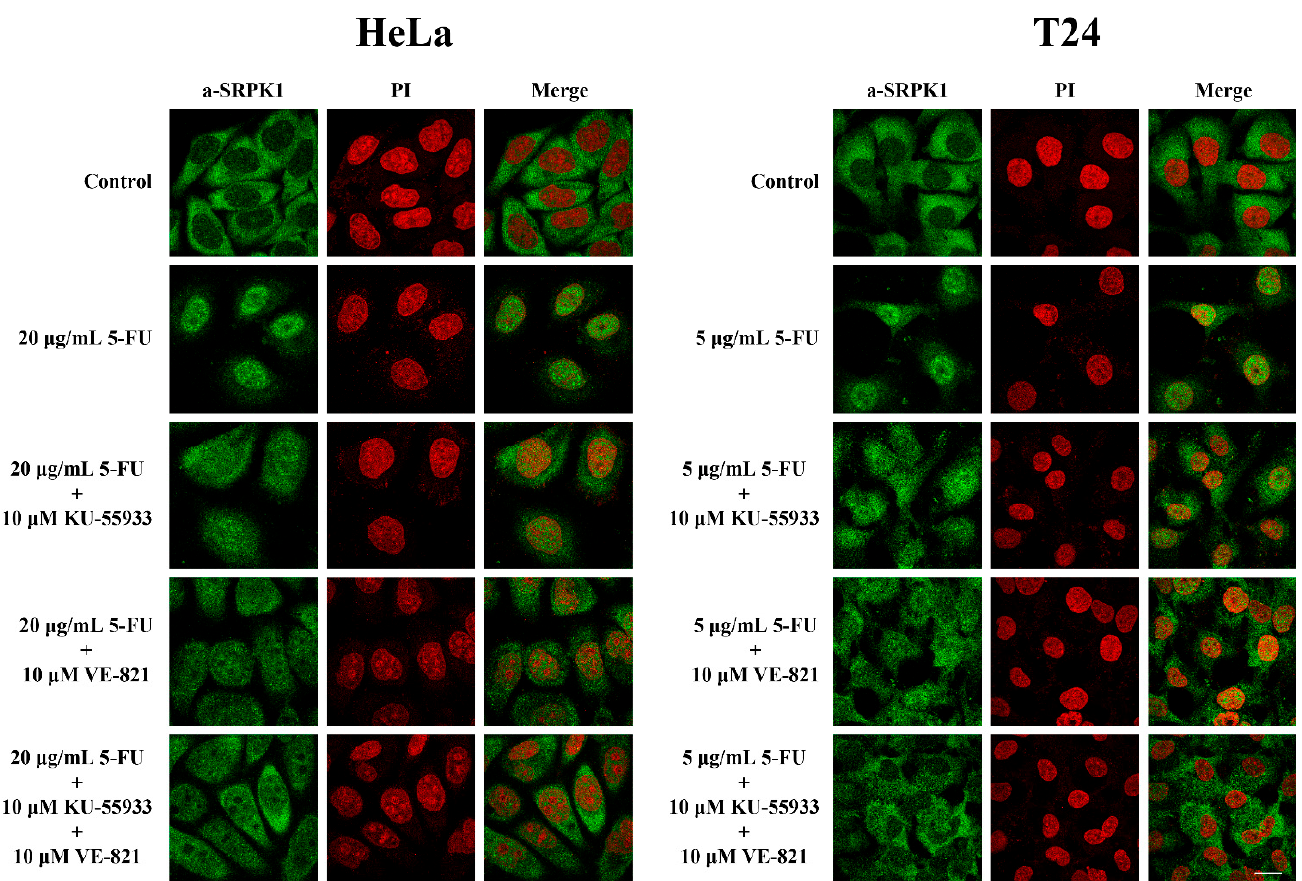
Figure 9. ATR/ATM inhibition significantly prevented the nuclear translocation of SRPK1 in 5-FU-treated HeLa and T24 cells. Fluorescent patterns of SRPK1 in HeLa ( left panel ) and T24 cells ( right panel ) treated either alone with 5-FU (20 μ g/mL in HeLa, 5 μ g/mL in T24) for 48 h, or co-treated for 48 h with 5-FU plus 10 μ M KU-55,933, 5-FU plus 10 μ M VE-821, or 5-FU plus 10 μ M KU-55,933 plus 10 μ M VE-821. SRPK1 was detected using the anti-SRPK1 monoclonal antibody, while nuclei were stained with PI. Scale bar: 10 μ M.